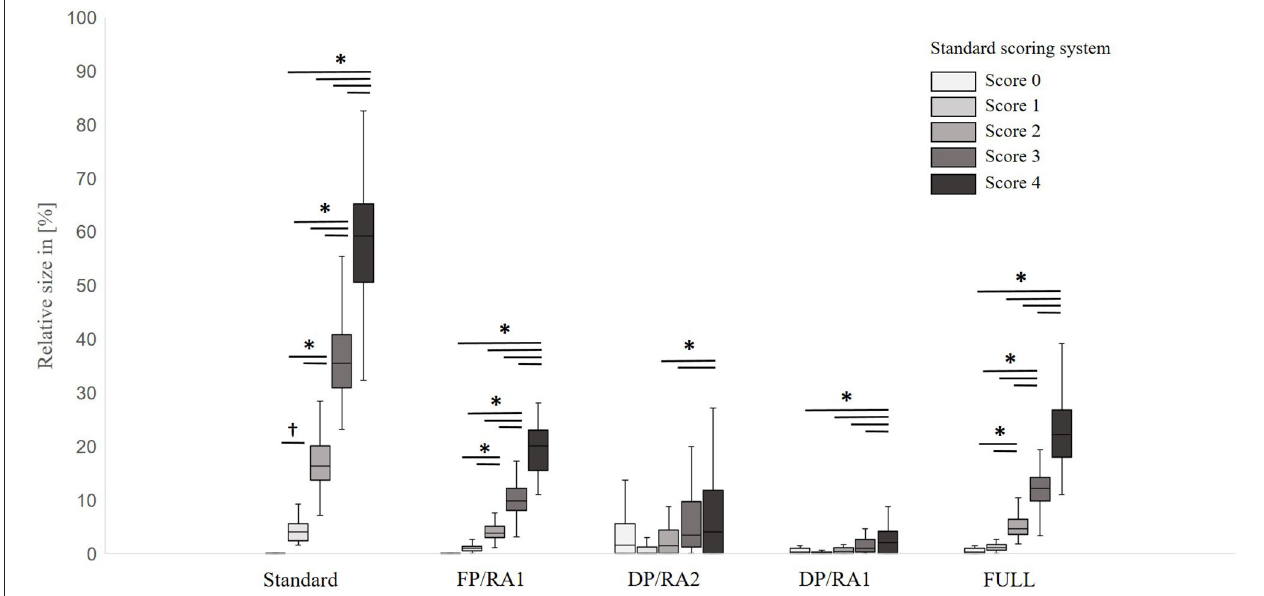
FIGURE 6 | Boxplots of the relative size of alterations measured for the different parameters by scoring level of the standard FPD scoring system. Data are presented as boxplots (data range, median, lower quartile and upper quartile; outliers are not included in the graph); n = 250, (Standard, alteration on the metatarsal pad in relation to the size of the metatarsal pad; FP/RA1, alteration on the metatarsal pad in relation to the total foot; DP/RA2, alteration on digital pads in relation to the metatarsal pad; DP/RA1, alteration on the digital pads in relation to the total foot; FULL, alterations on metatarsal pad and digital pads in relation to the total foot), *indicates a p < 0.05, † indicates a p < 0.1.